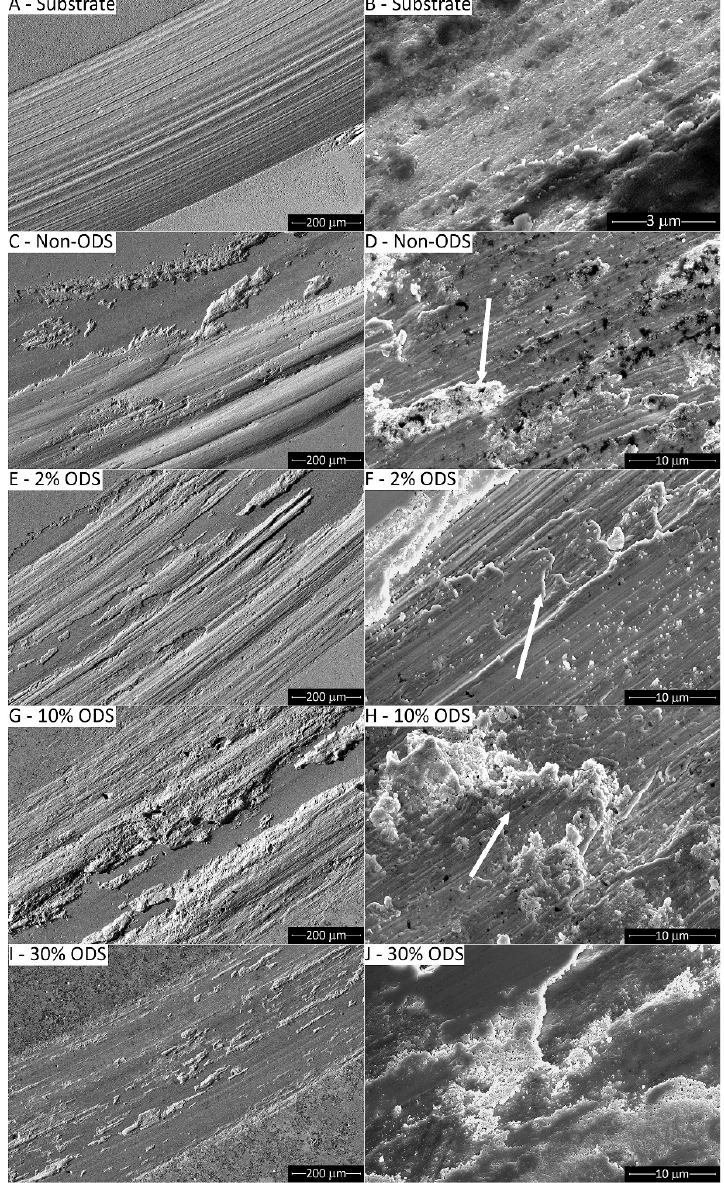
Figure 16. SEM images of samples’ surface after wear experiments performed at 750 °C; ( A , B ) uncoated substrate; and CoNiCrAlY coatings with ( C , D ) 0%, ( E , F ) 2%, ( G , H ) 10%, and ( I , J ) 30% Al 2 O 3 . Arrows indicate evidence of plastic flow and adhesive tearing (Reproduced from [9] with permission from Else- vier).